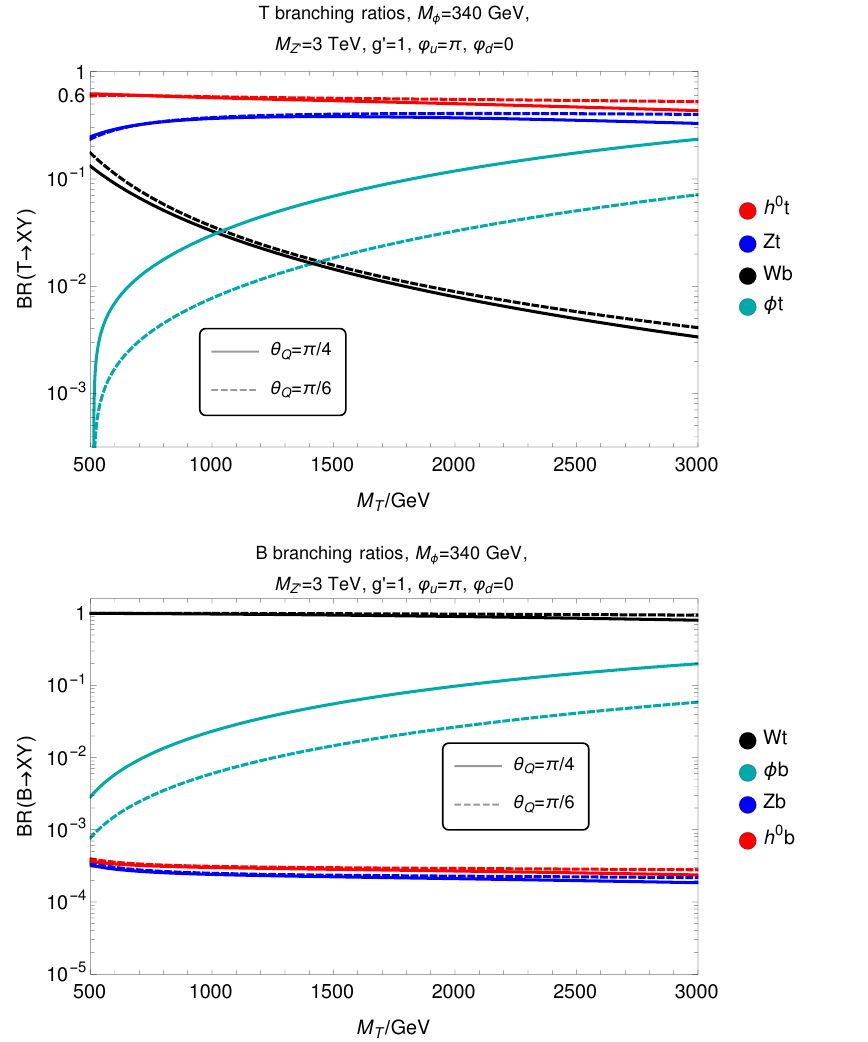
Figure 3. BRs of T (upper) and B (lower) as a function of the VLT mass for θ Q solid lines and θ Q = π/ 6 drawn in dashed 34